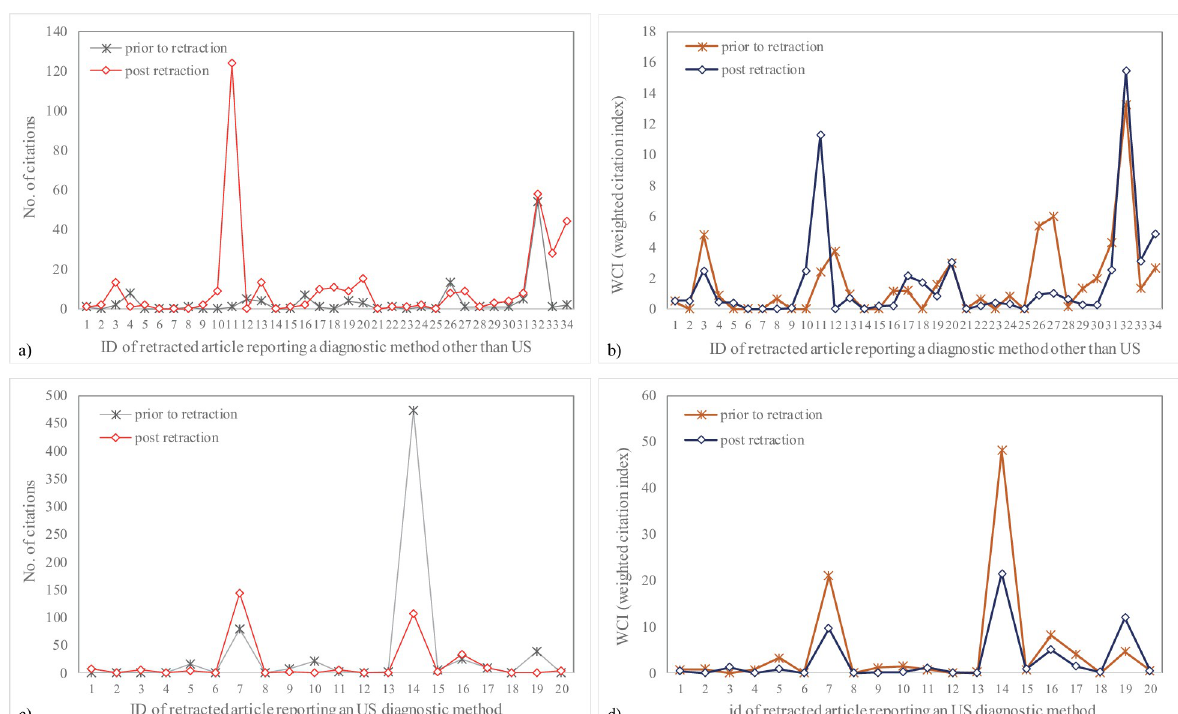
Fig 3. Retracted articles that reported a diagnostic method. Other diagnostic methods than US: a) Absolute number of citations, b) Number of citations weighted by citation window. US diagnostic method: c) Absolute number of citations, d) Number of citations weighted by citation window.